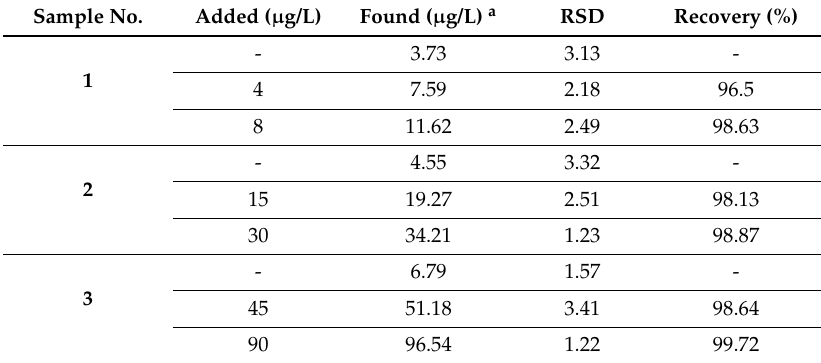
Table 5. Results for the detection of Pb(II) in several soil sample